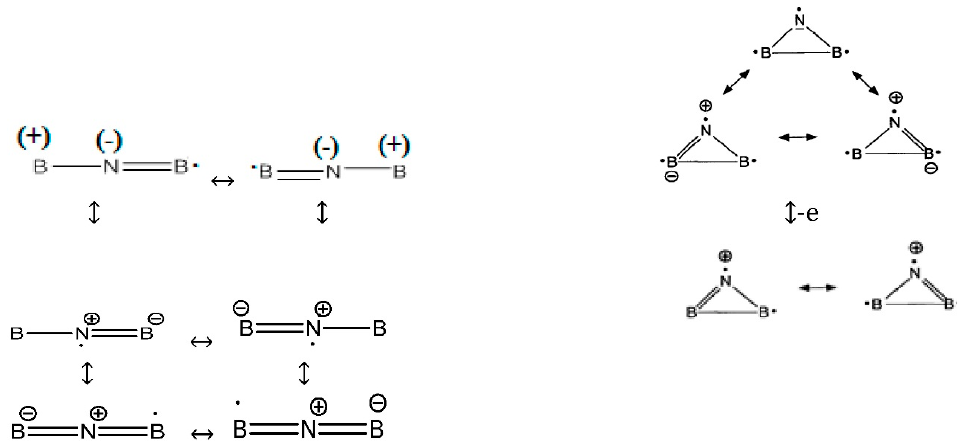
Scheme 2. Lewis structures representation of BNB in three forms of radical, anion and